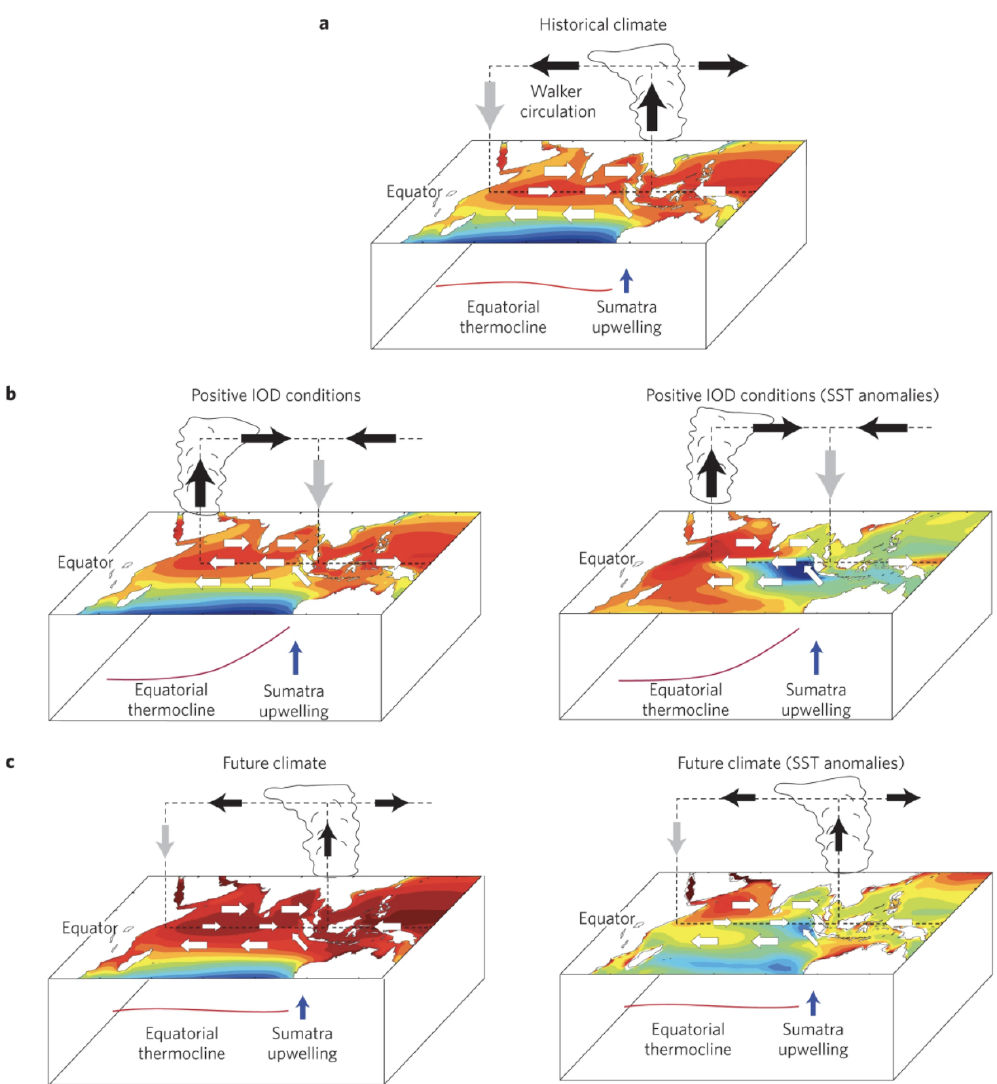
Figure 17. Historical austral spring mean climate and positive IOD conditions for the 20th century and future austral spring mean climate. (a) Historical mean climate, indicating SSTs, surface winds, the associated atmospheric Walker circulation, the mean position of convection, and the thermocline. In the western Indian Ocean, the descending branch is broad and not well defined, as indicated by a grey arrow. (b) Typical conditions during a positive IOD event. (c) Projected future mean climate based on a CMIP5 multi-model ensemble average. Diagrams with total SST fields are shown on the left; diagrams with SST anomalies referenced to the 1961–1999 mean for (b) and referenced to the basin mean for (c) are shown on the right. Reprinted from Cai et al. (2013) with permission from Springer